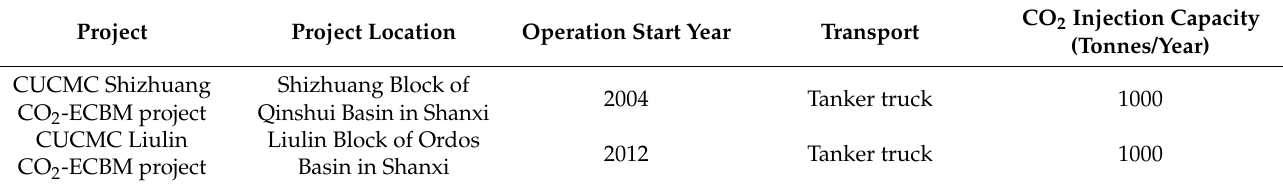
Table 7. CO 2 -ECBM projects in China